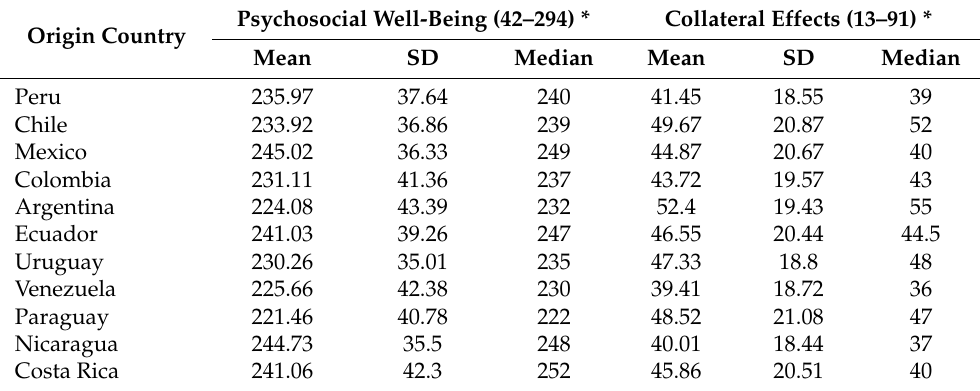
Table 4. Total scores for collateral effects according to the origin country of